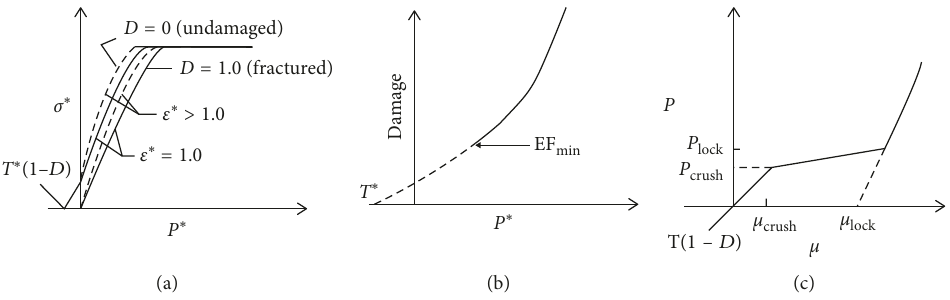
Figure 3: Holmquist–Johnson–Cook constitutive model.